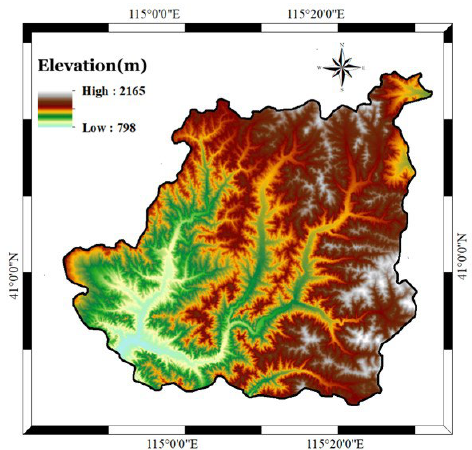
Figure 1. Chongli district, Zhangjiakou City, Hebei Province, China.